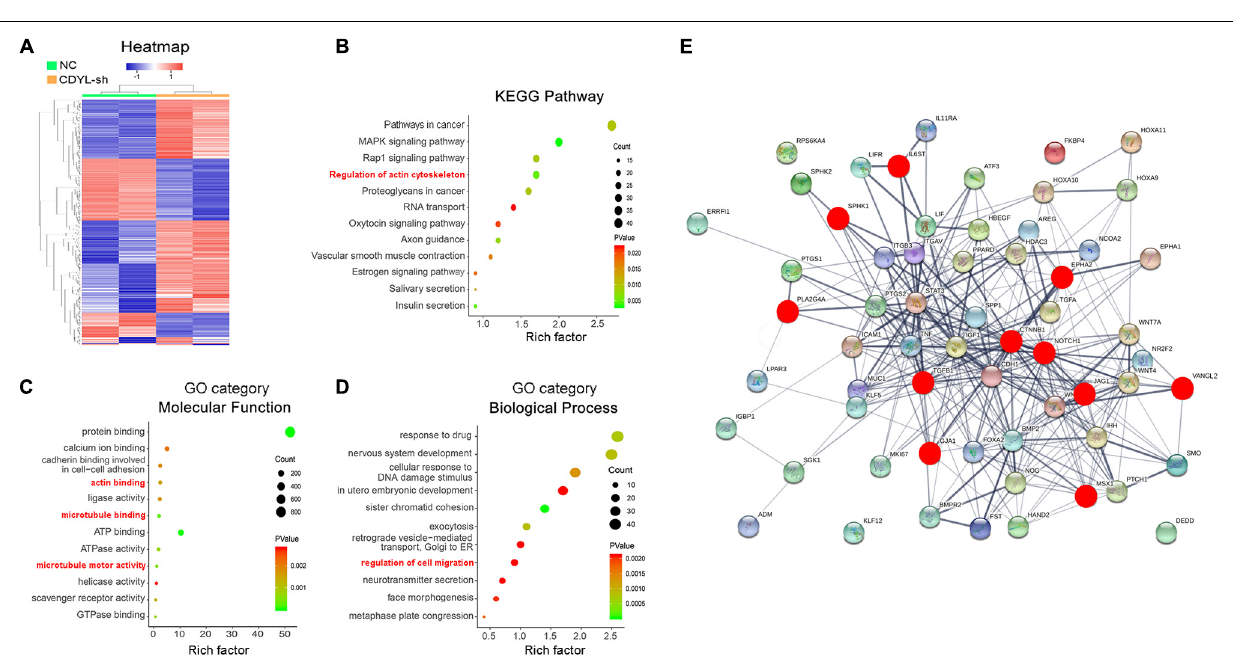
FIGURE 4 | Analysis of transcriptome alternation in CDYL knockdown Ishikawa cells. (A) Hierarchical clustering of differentially expressed genes (DEGs). Rows in the heatmap correspond to DEGs, and columns correspond to individual samples. Functional enrichment analysis of DEGs, including KEGG pathway (B) , GO category molecular function (C) , and biological process (D) . (E) Protein–protein interaction (PPI) network analysis of the top 56 genes involved in the endometrial receptivity and implantation. Genes affected by the CDYL knockdown are marked in